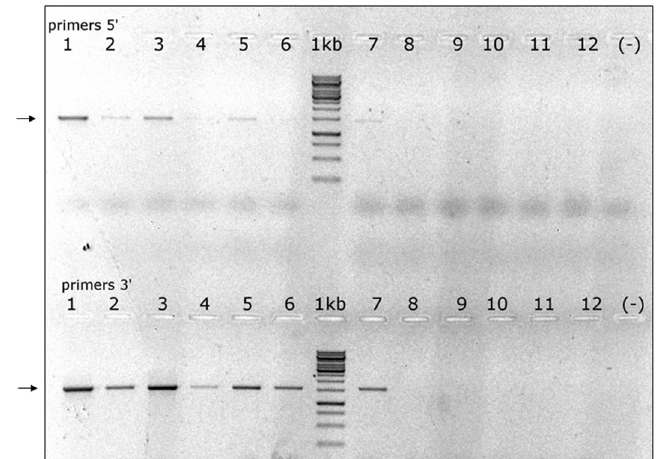
Figure 6. Presence of VDV-4 in V. destructor mites and A. cerana drones: lanes 1–3 and 4–6 pools of 5 V. destructor cDNAs each from colonies 3c and 4c, respectively; lanes 7–9 and 10–12 individual A. cerana drones, 3 per colony; lanes (−) nontemplate control; lanes 1 kb, GeneRuler Marker TM 1 kb DNA ladder. Arrows: VDV-4, Upper panel VDV-4 genome 5’-end primers VDV4-1451F and VDV4-2889R, expected fragment 1438 bp; lower panel VDV-4 genome 3’-end primers VDV4-6242F and VDV4- 7818R, expected fragment 1576 bp.